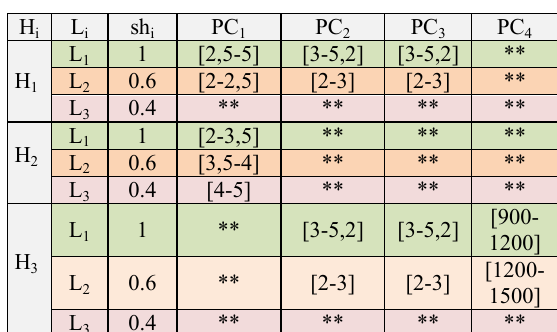
Table 4. Levels of hypotheses considered and (